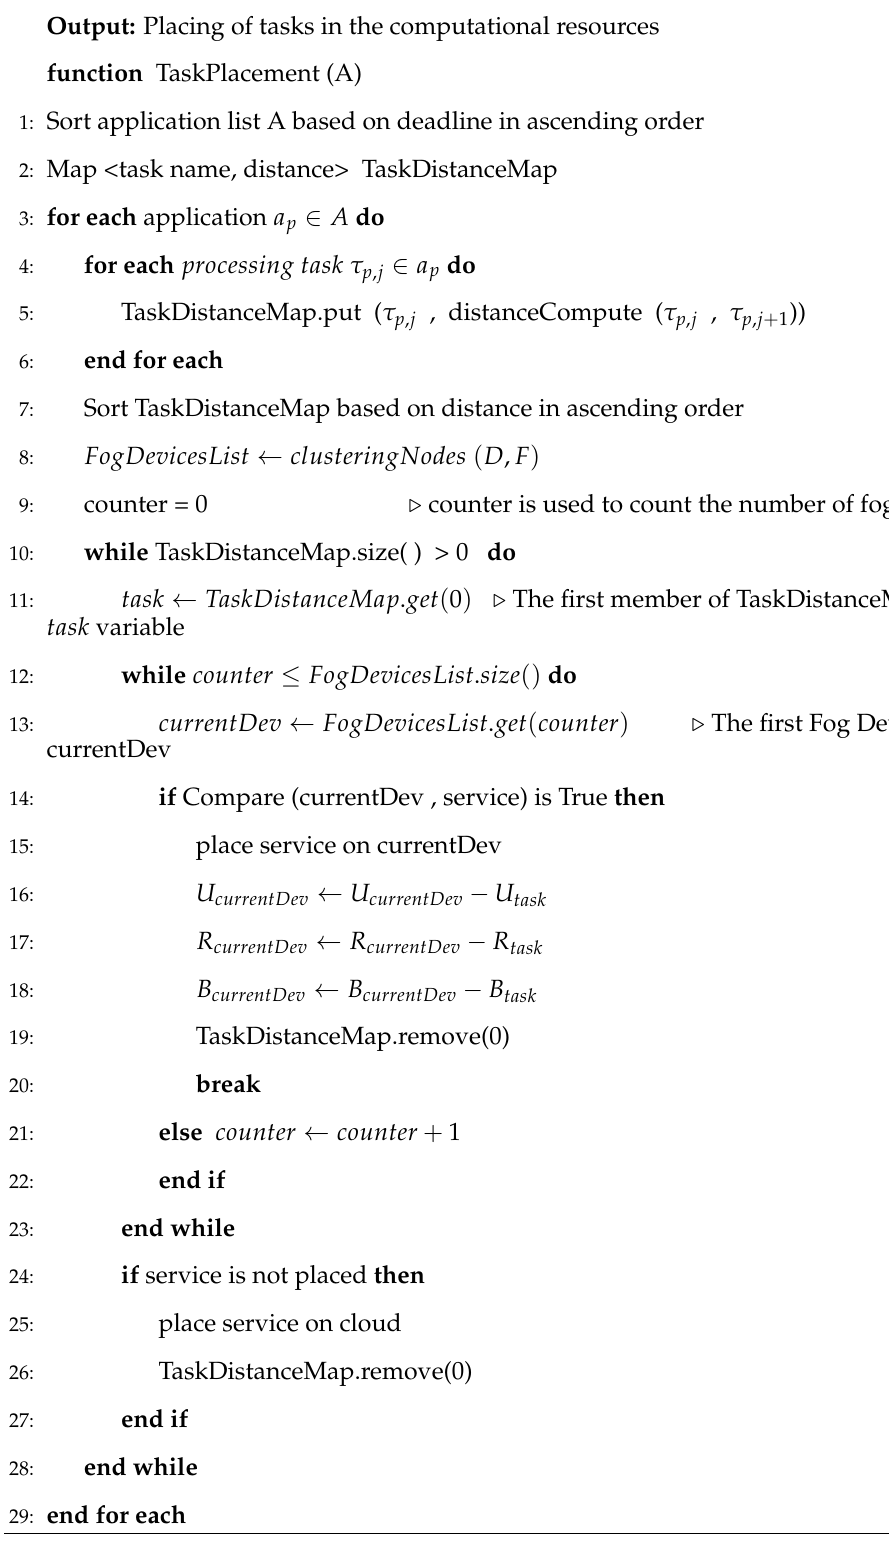
Algorithm 1 Service Placement